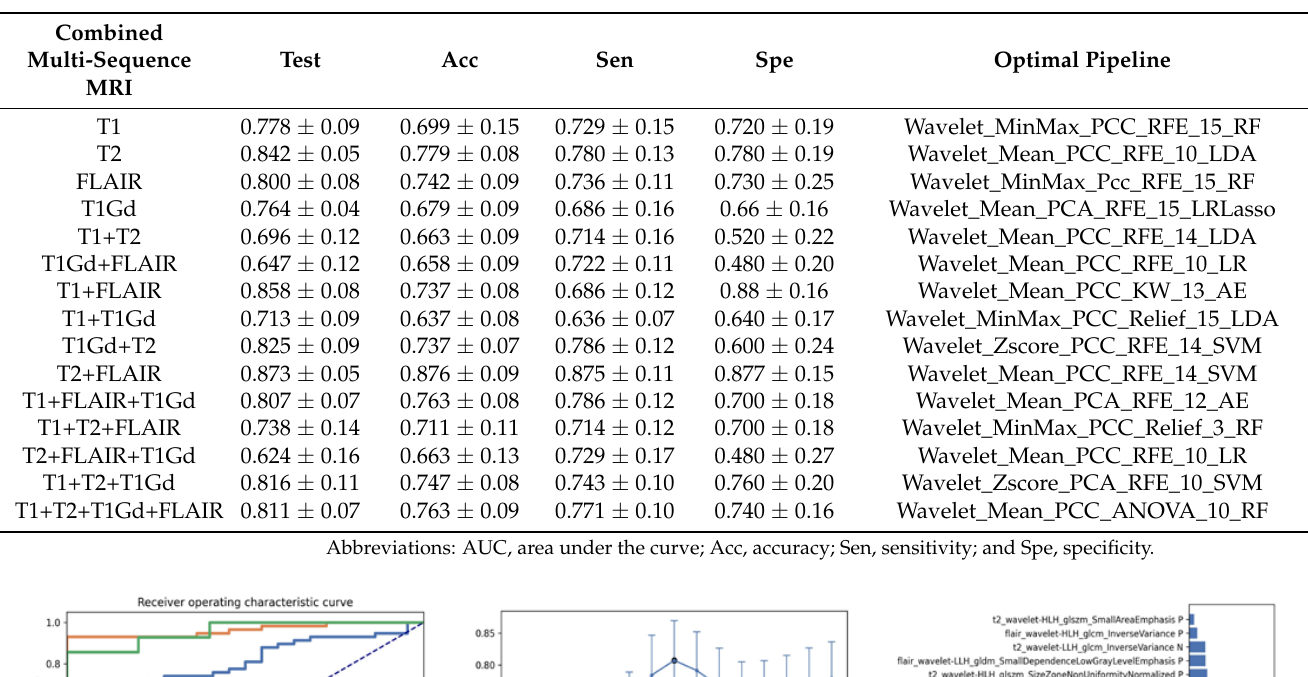
Table 3. The best performance of each combined multi-sequence MRI generated by the “6-Step” general radiomics model.